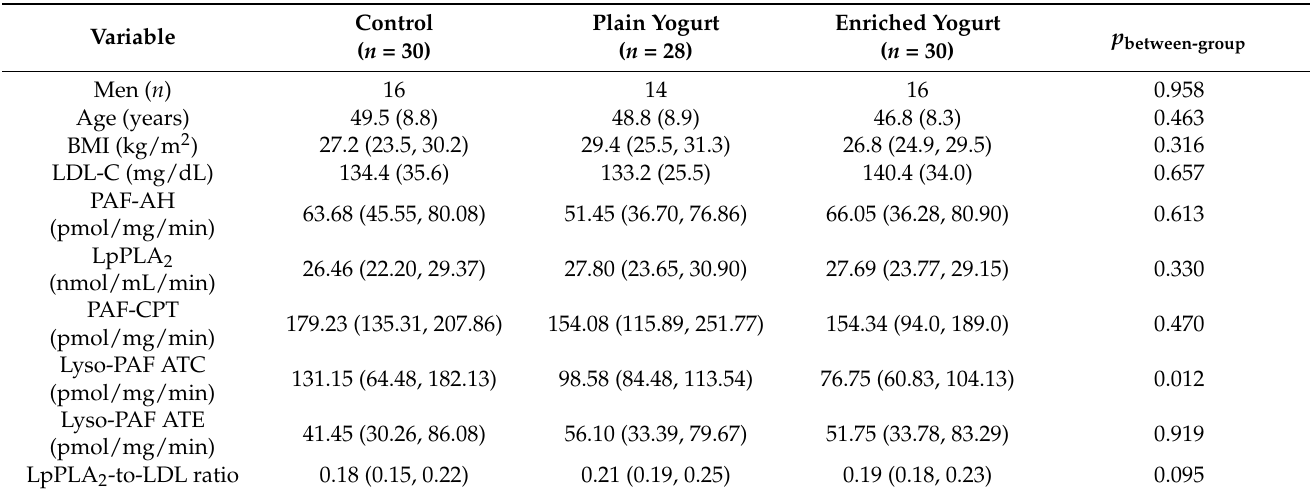
Table 1. Baseline characteristics of participants randomly assigned to each intervention (ITT analysis).